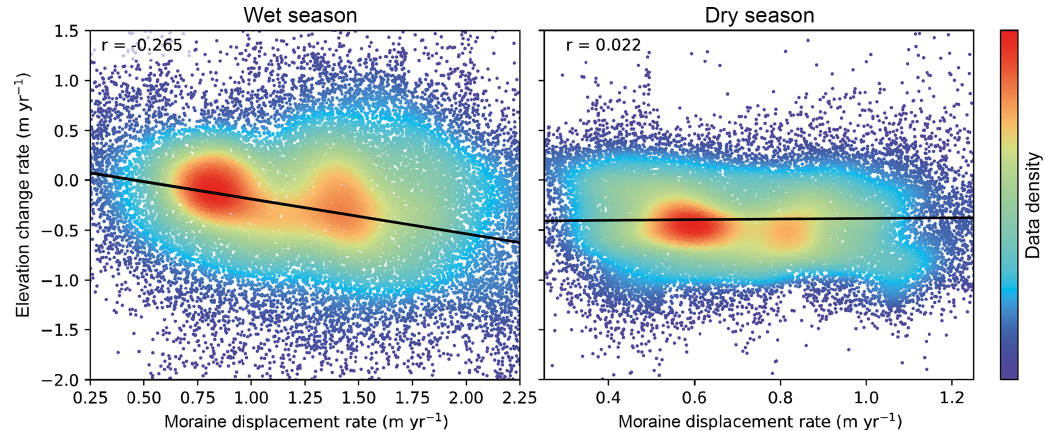
Figure 8. Relation between elevation change and moraine velocity in the wet and dry seasons. In the wet season, high velocities occur with higher surface lowering rates. Debris apron displacement is likely caused by a slumping movement due to sub-apron ice melt. No such relation exists in the dry